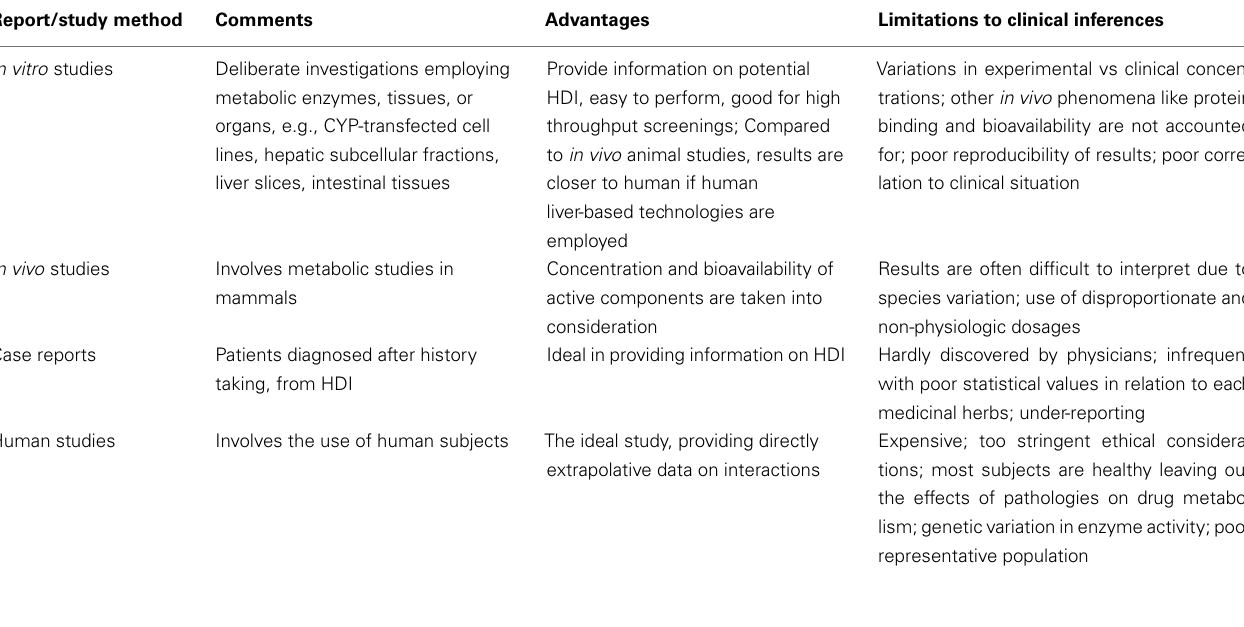
Table 1 | Comparison of study methods available for